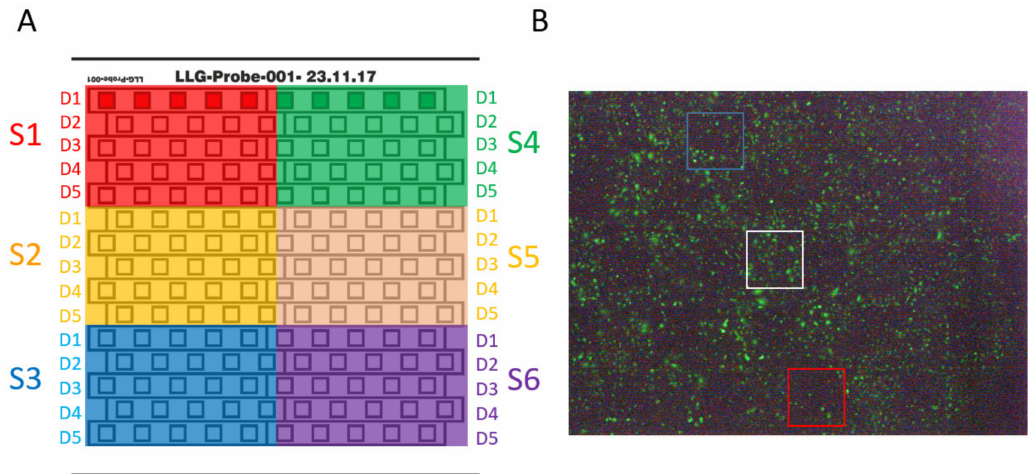
Figure 3. Sample preparation and examination. ( A ) Sample overview for the stainless-steel plates. The colored numbers outside of the square signify the six di ff erent structure types (S1–S6). Each structure is comprised of five columns and five rows, where the columns represent five di ff erent depths (D1–D5) and the rows are replicas for each structure / depth combinations. ( B ) Example of fluorescence microscopy image of structured (S5 D1–5) stainless steel plate. Fields with no structure (white), shallow (D1, blue), and deep structures (D5, red) are